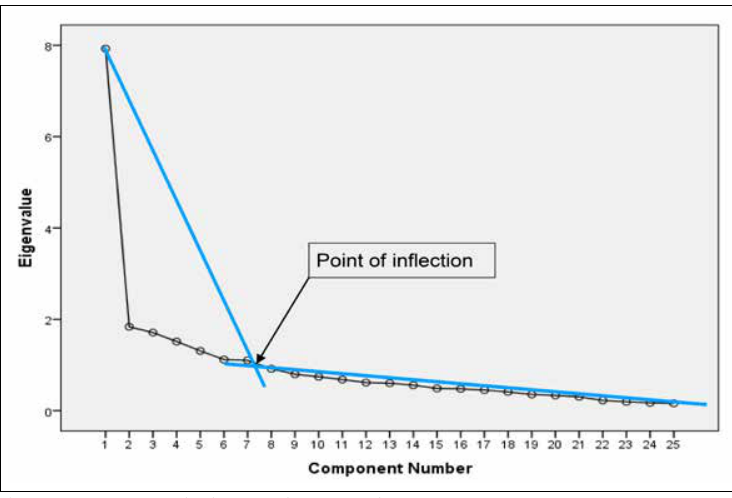
Figure 1: Scree plot for factors of BIM benefits The scree plot confirms the finding of retaining seven components. As a result, components from eight to twenty-five are not significant and thus not included for analysis. Table 6 shows the seven components that are meaningful to retain, where component 1 explains 31.716% of the total variance; component 2, 7.344%; component 3, 6.840%; component 4, 6.058%; component 5, 5.232%; component 6, 4.474%, and component 7,